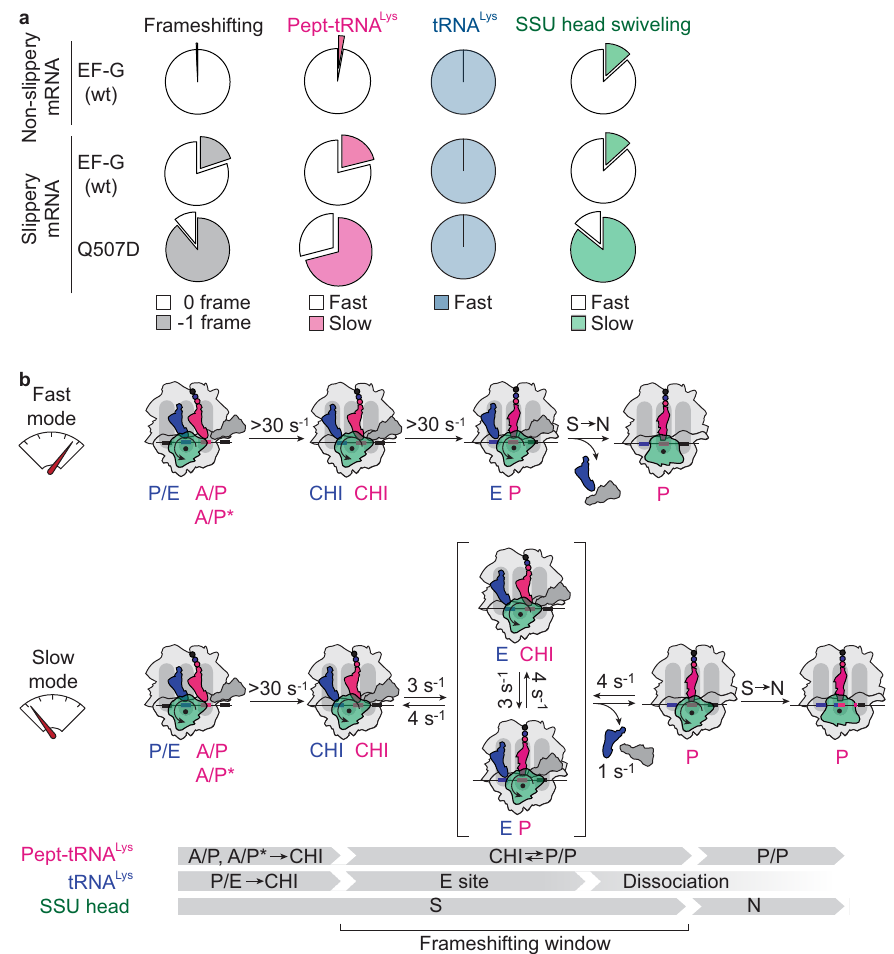
Fig. 7 Translocation trajectories correlating with frameshifting. a Pie charts comparing the frameshifting ef fi ciency (gray) with the distribution of translocation rates for pept-tRNA (magenta) and deacylated tRNA (blue) and SSU head domain back rotation (green) on non-slippery and slippery mRNA with EF-G(wt) and EF-G(Q507D). b Kinetic model of translocation on slippery mRNA. Majority of ribosomes translocate in fast mode with tRNAs moving synchronously to the POST state; back swiveling of the SSU head domain completes translocation. A fraction of ribosomes translocates in slow mode where pept-tRNA is trapped fl uctuating between CHI and P/P instead of moving to the POST state. Deacylated tRNA translocates rapidly and dissociates from the E site allowing pept-tRNA to sample 0- and – 1-frame codons. SSU head closure is delayed due to prolonged fl uctuations of pept-tRNA. Rates of the elemental reactions for pept-tRNA are indicated.